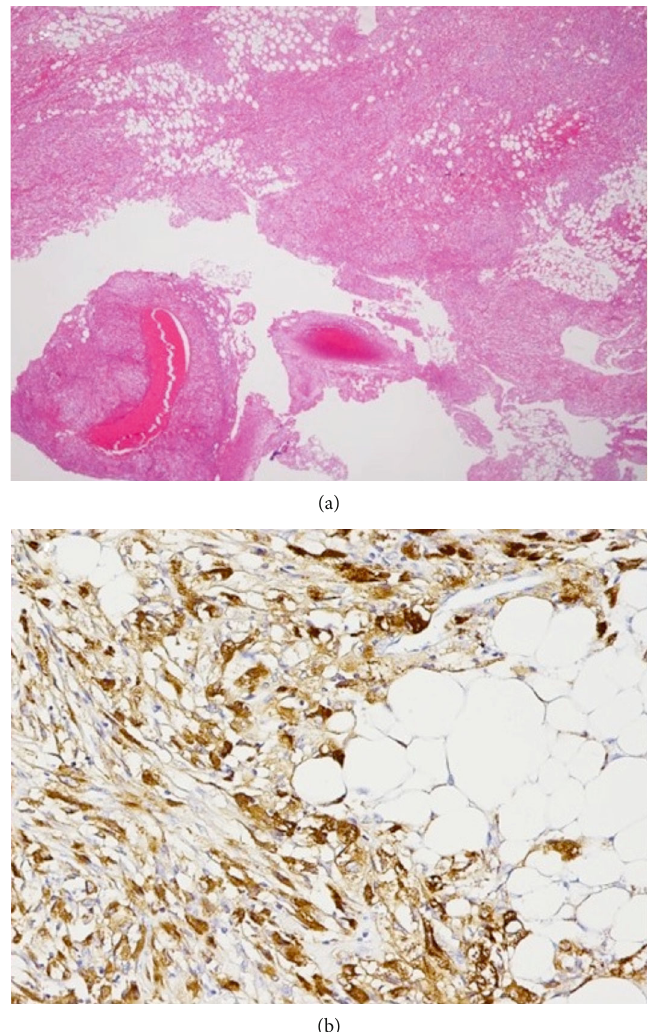
Figure 3: Histopathological fi ndings. (a) Hematoxylin – eosin stain ( × 40). The tumor consisted of mature adipose tissue, smooth muscle cells, and thick-walled abnormal vessels. (b) Immunostaining for HMB45, a marker of angiomyolipoma, was positive in the tumor cells ( ×